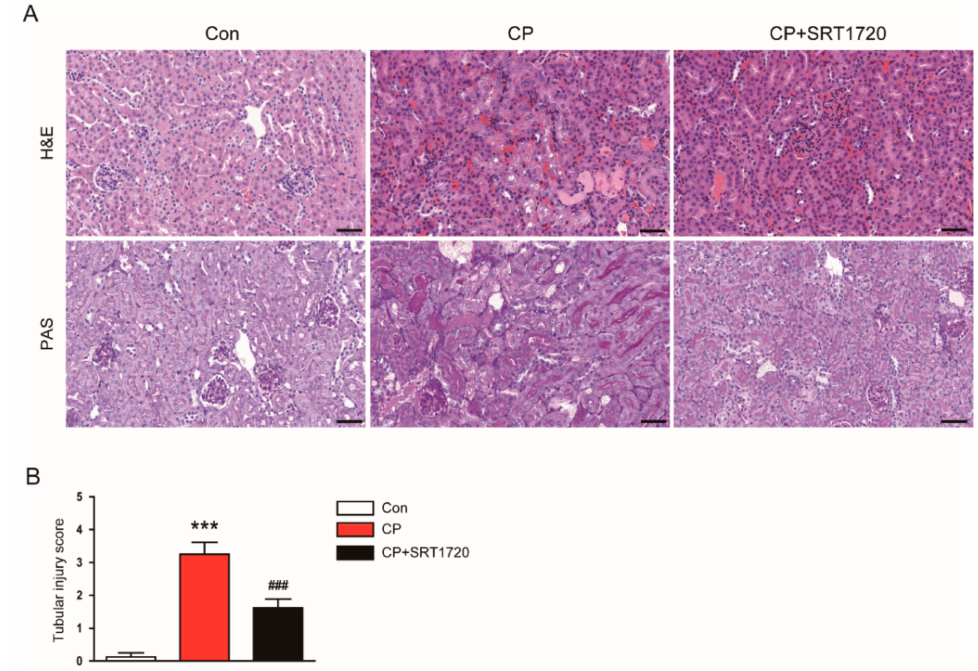
Figure 2. E ff ects of SRT1720 on renal histology in mice treated with cisplatin. ( A ) Representative images of hematoxylin and eosin (H&E) and periodic acid Schi ff (PAS) staining. Scale bar: 50 µ m. ( B ) Tubular injury score. *** p < 0.001 vs. Con. ### p < 0.001 vs.